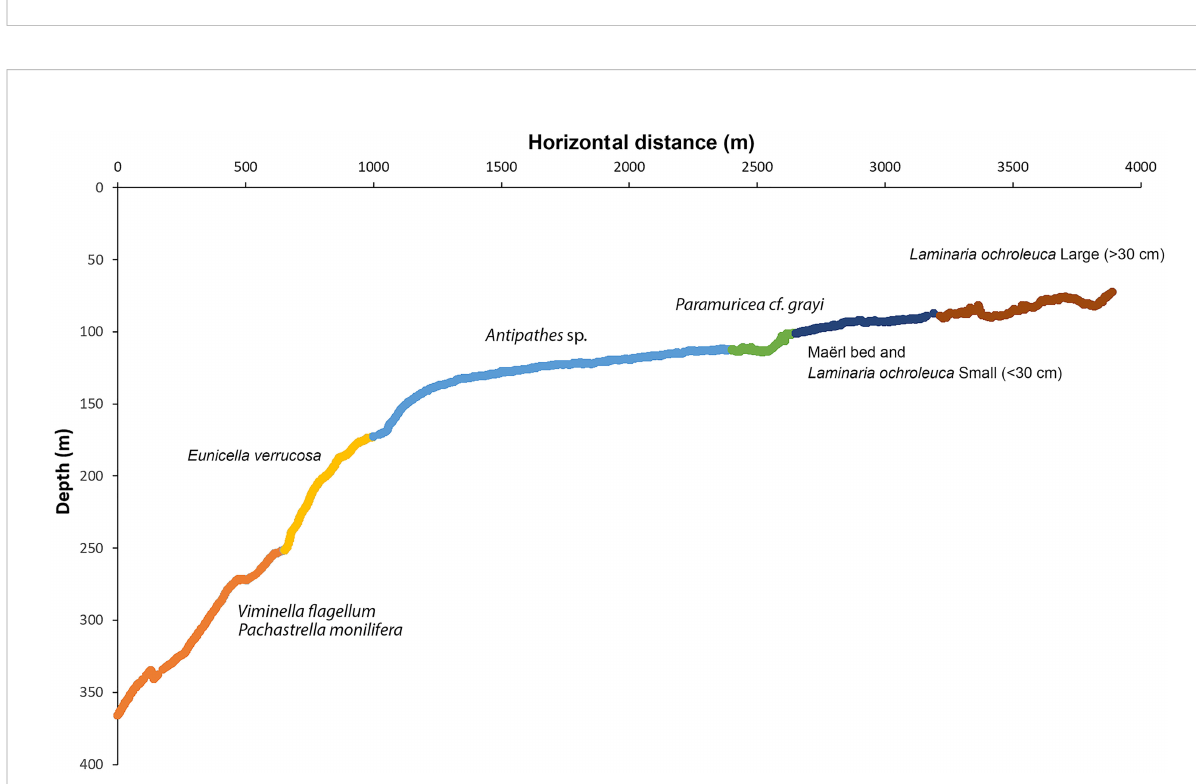
FIGURE 9 Distribution of video samples along the depth gradient explored in the Madeira-Desertas Ridge classi fi ed as six biotopes, with characteristic species identi fi ed with TWINSPAN. Biotope 1 (orange) – Mixed Viminella and sponge garden on exposed rock on deep slope; Biotope 2 (yellow) – Eunicella garden on exposed rock on upper slope; Biotope 3 (light blue) – Antipathes garden on level sandy bottom; Biotope 4 (green) – Paramuricea garden on coralline-encrusted bedrock; Biotope 5 (dark blue) – Maërl bed; Biotope 6 (brown) – Kelp forest.